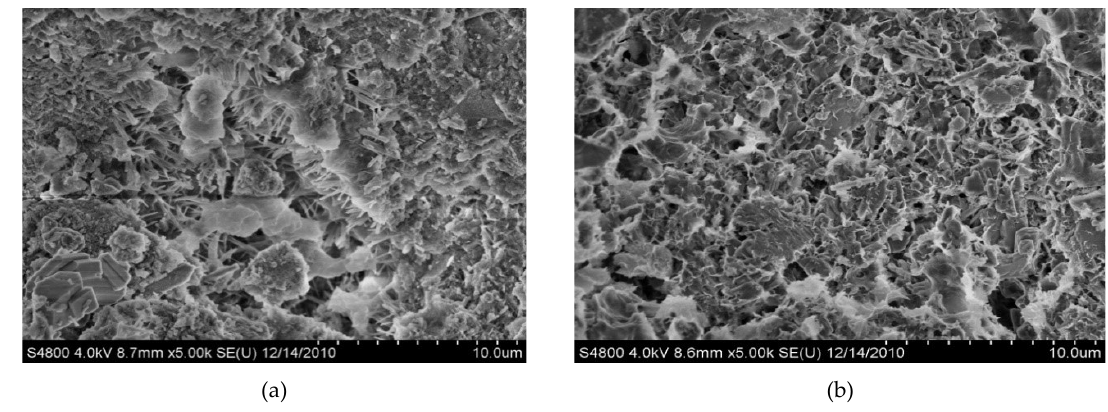
Figure 7. Scanning electron microscopy ( SEM) of DGSC. ( a ) at 3 days (5k); ( b ) at 28 days (5k).